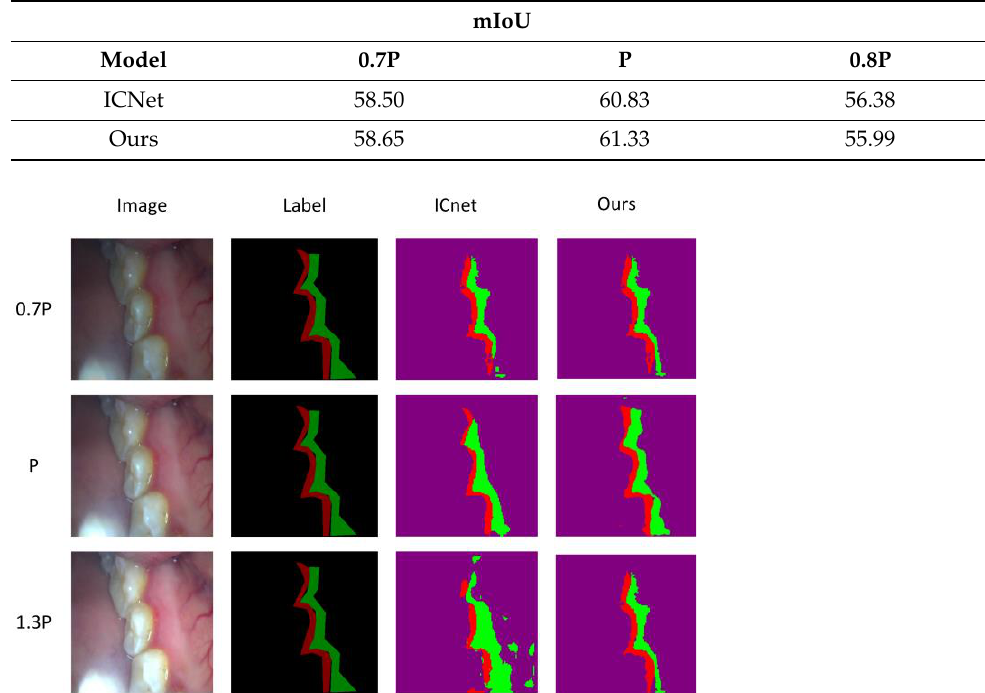
Table 4. mIoU comparison of our method with the ICNet method at different luminance.